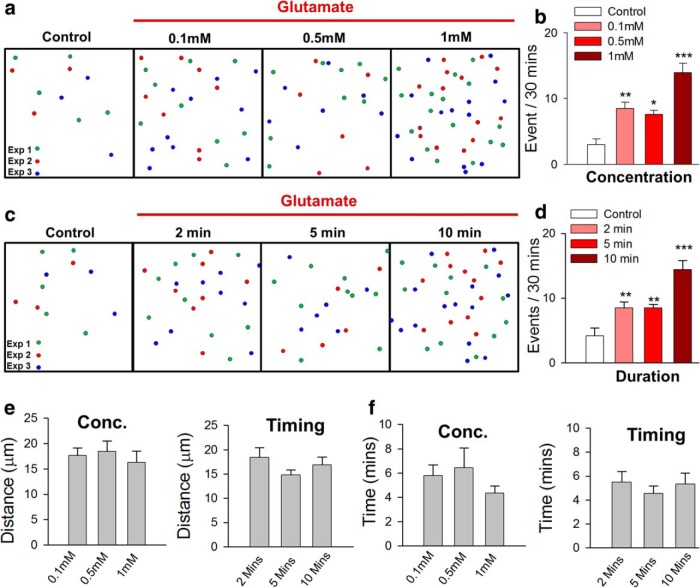
Characteristics of glutamate-induced MPCs. a–d, Schematic representation (a, c) and quantitative summary (b, d) showing the occurrence of MPC events at various glutamate concentrations for 10 min (a, b) and various time points at 1 mm (c, d). n = 6–11 slices each. e, f, Microglia respond from similar distances in all conditions of glutamate exposure tested. Glutamate-induced MPCs show similar features in the different conditions. **p < 0.01; ***p < 0.001 compared with control.